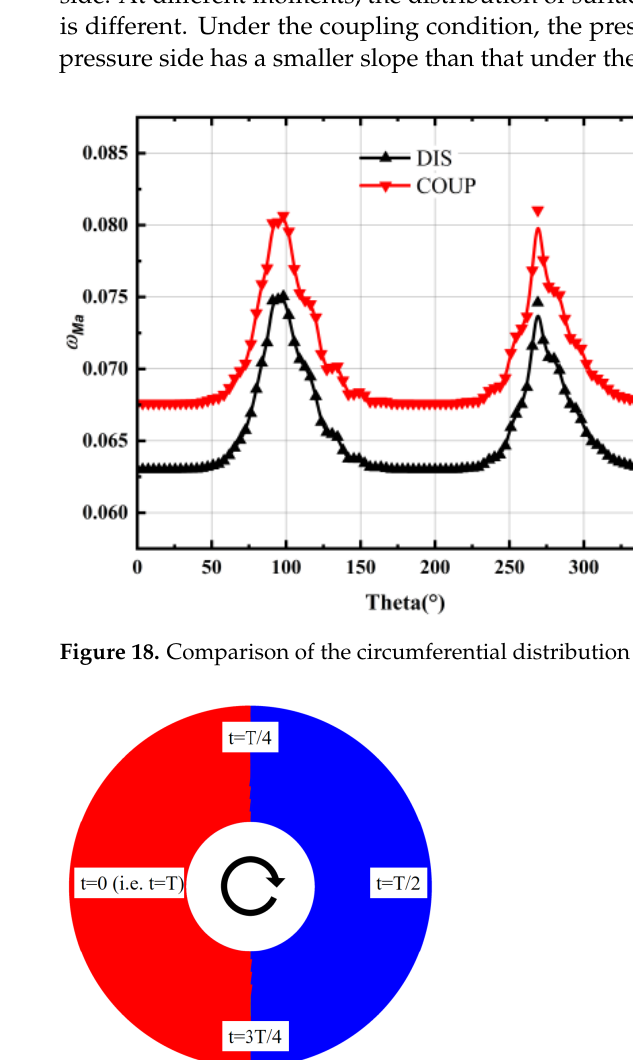
Figure 19. Measurement positions selection within one revolution.